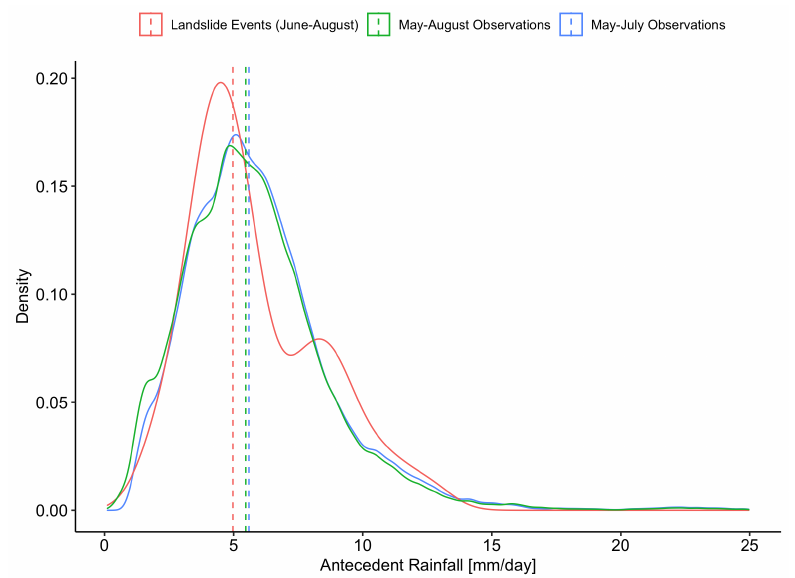
Figure 5. Density distributions of antecedent rainfall of landslide events, and the CMFD observations for May to August and May to July from 1995 to 2005.